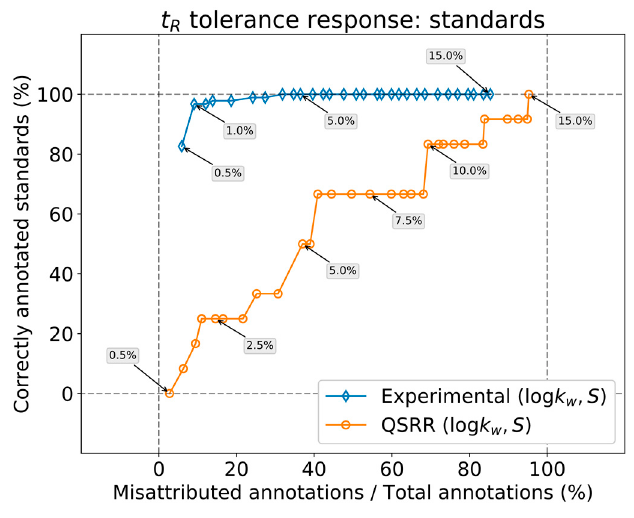
Figure 4. Annotation ratios.